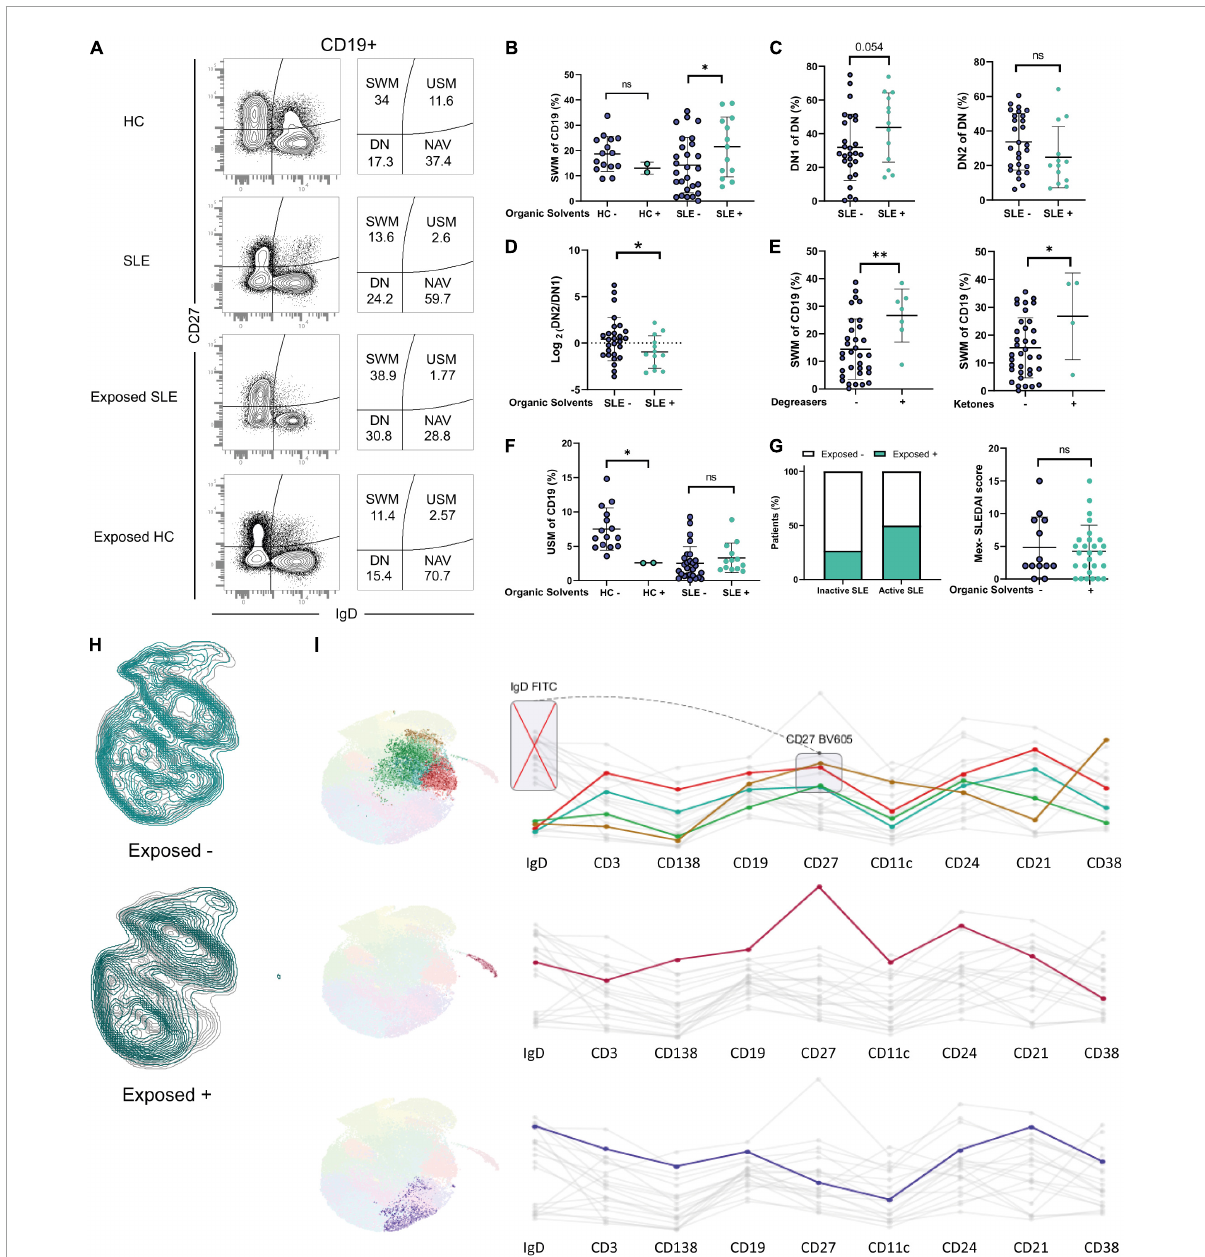
FIGURE5 Distribution of B cells in patients and healthy occupationally exposed to Organic Solvents. (A) Representative dot plots showing increased SWM cells in exposed patients. (B) SWM cells in exposed or non-exposed HC and SLE patients. (C) DN1 and DN2 cells in exposed or non-exposed patients. (D) DN2/DN1 ratio in exposed or non-exposed patients. (E) SWM cells and exposure to degreasers and ketones in patients. (F) USM cells in exposed or non-exposed HC and SLE patients. (G) Percentage of exposed inactive and active patients and Mex-SLEDAI index in exposed or not patients. (H) Dimensionality reduction analysis in exposed or non-exposed patients. (I) Clusters with a differential expression when comparing between exposed or non-exposed patients and its markers. * P ≤ 0.05; ** P ≤ 0.01; *** P ≤